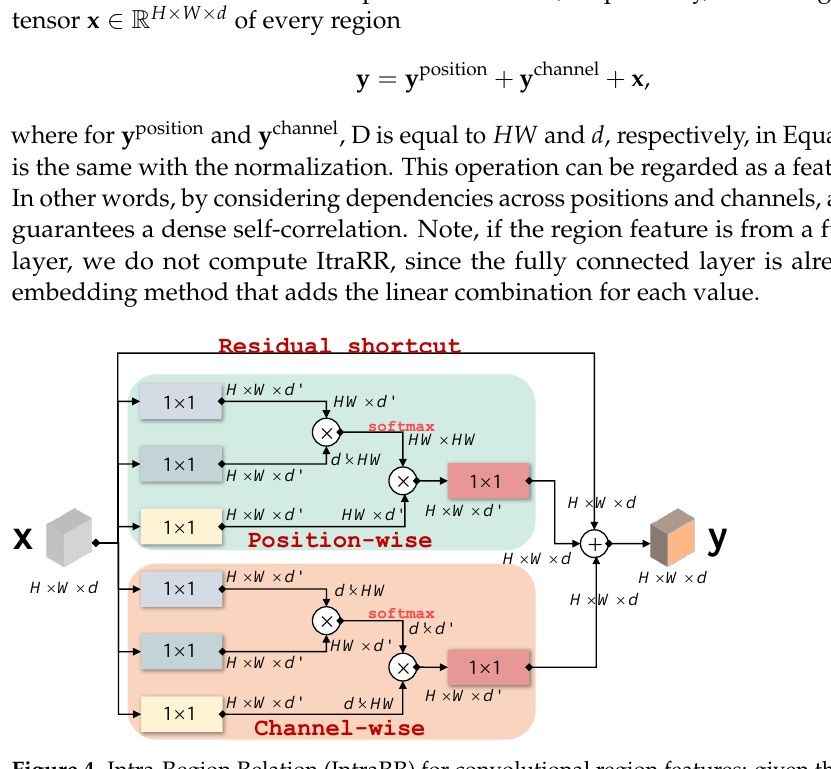
Figure 4. Intra-Region Relation (IntraRR) for convolutional region features: given the feature map of a region x ∈ R H × W × d , IntraRR computes the relations in position-wise and